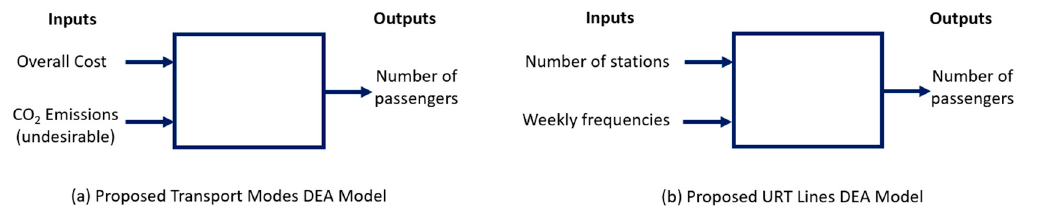
Figure 5. ( a )Transport modes efficiency and ( b ) URT lines efficiency DEA